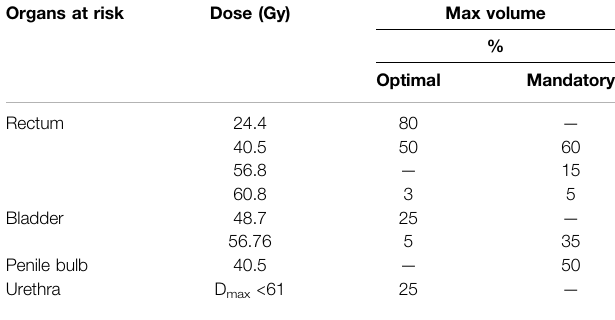
TABLE 2 | Chosen OAR-related DVH parameters for the evaluation of PSCT, PBCT, and AICT approaches from the PRISM study. Organs at